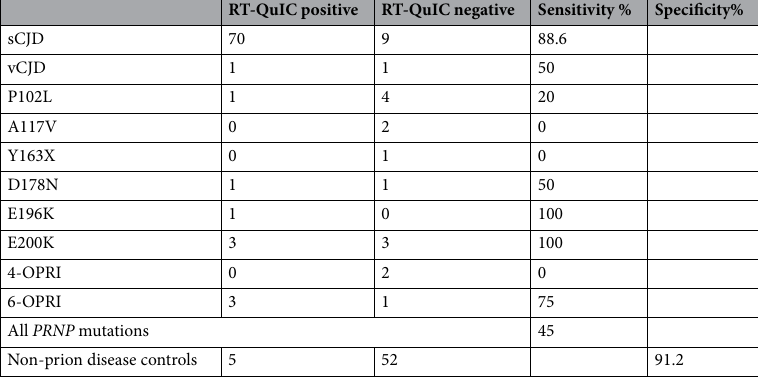
RT-QuIC positive RT-QuIC negative Sensitivity % Specificity% sCJD